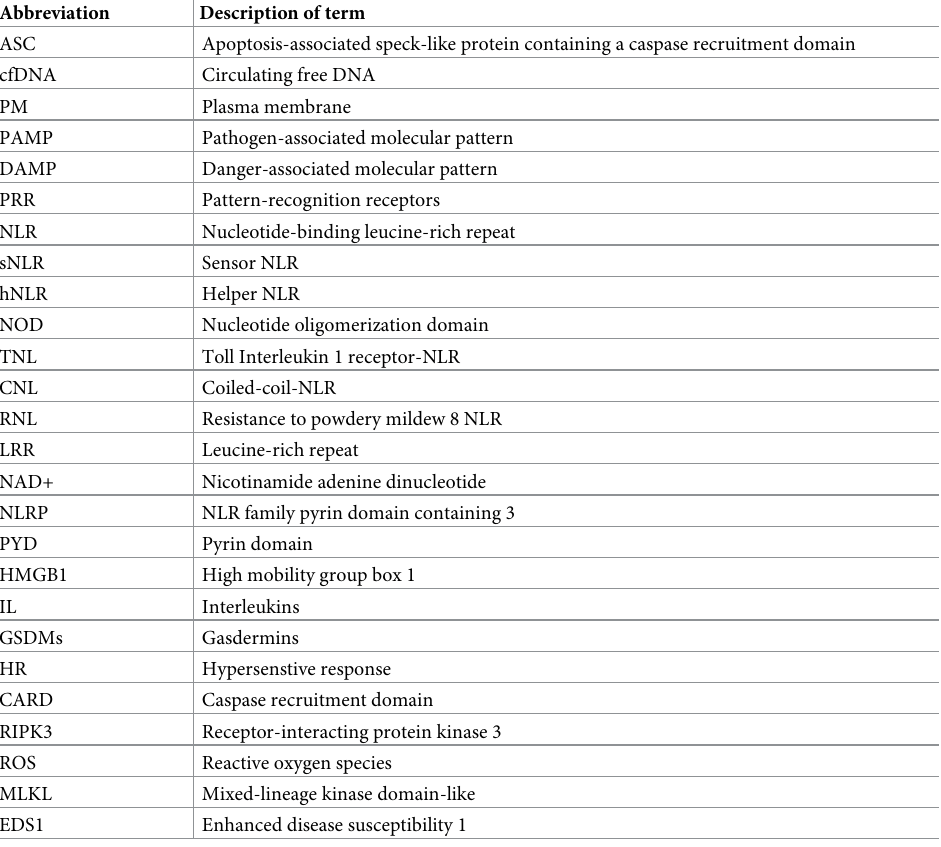
Table 1. Abbreviation